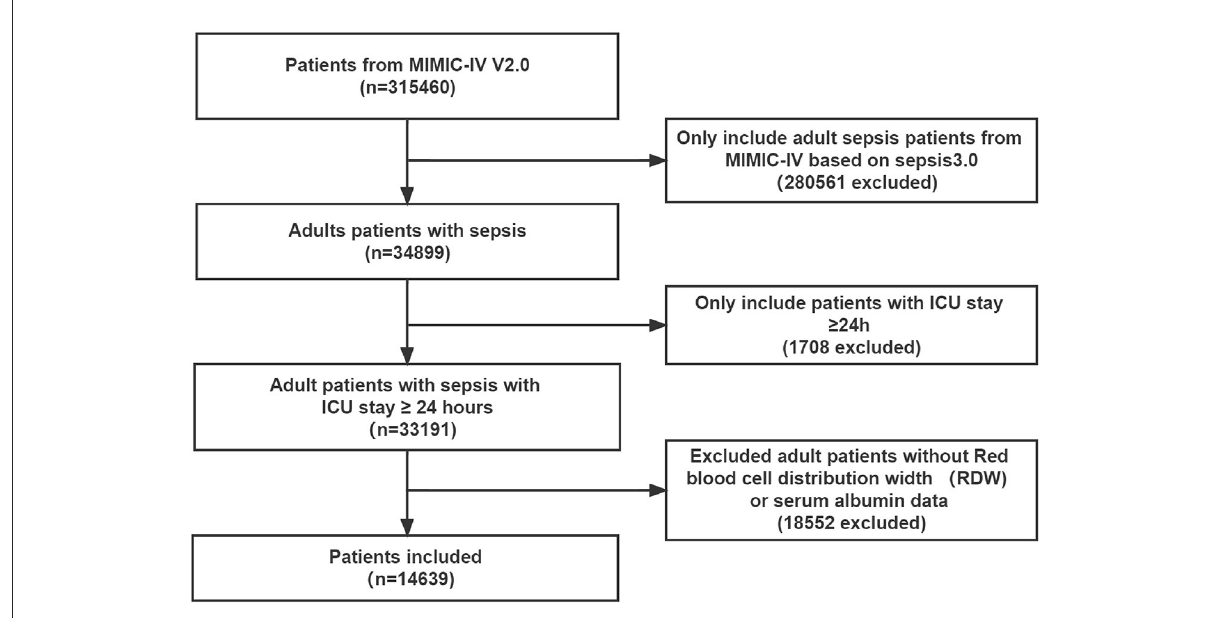
FIGURE1 Flowchart of study patient enrollment. ICU, intensive care